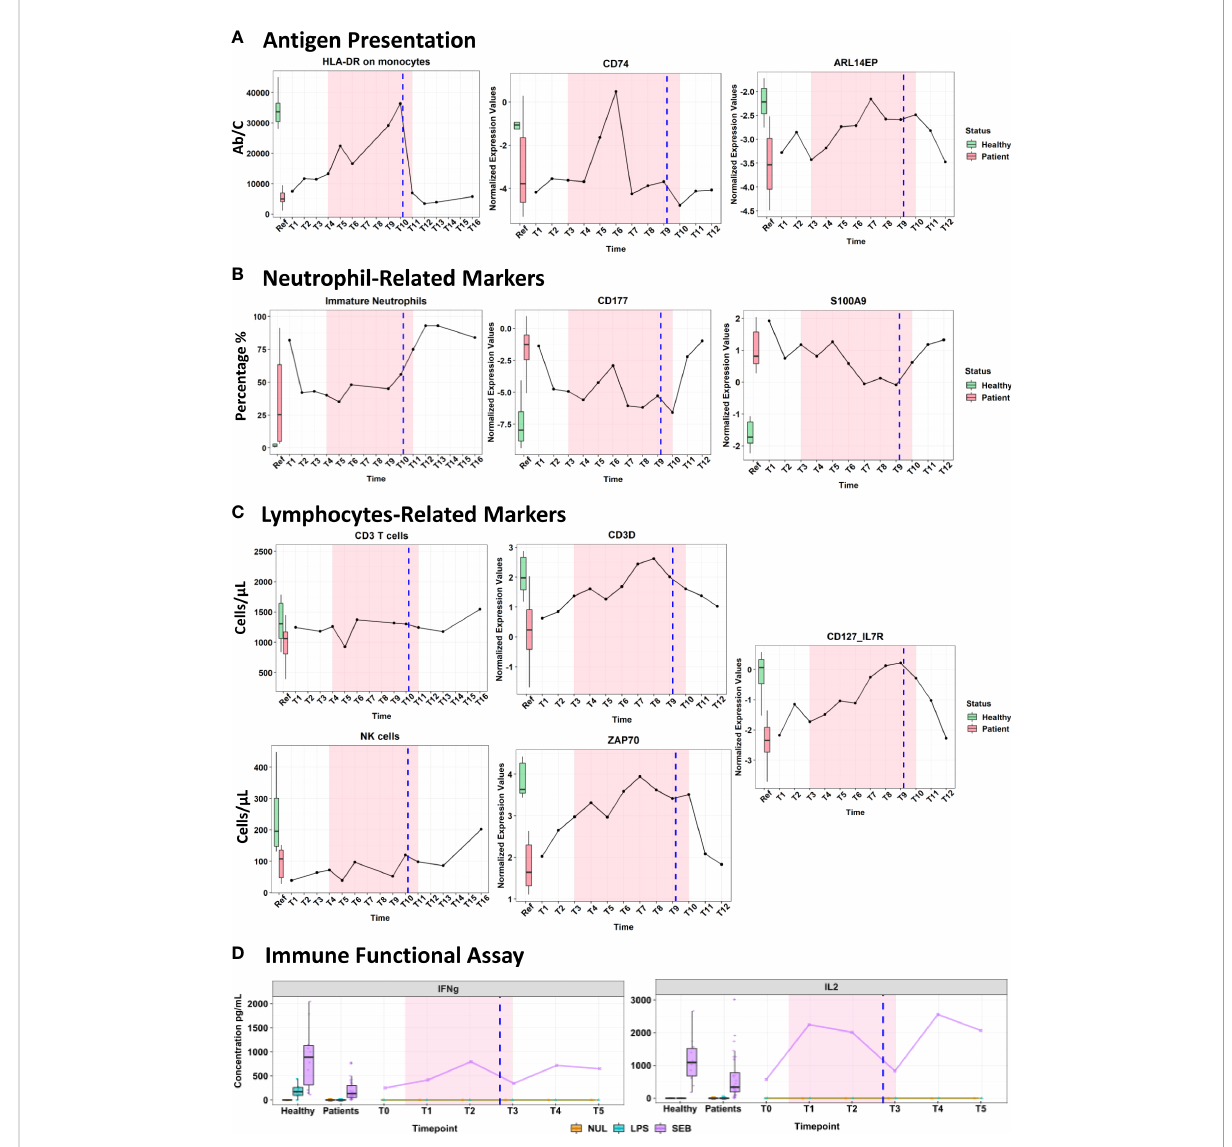
FIGURE 2 Immunomonitoring of cell surface markers using fl ow cytometry, transcriptomic analysis using the Immune pro fi ling Panel (IPP) prototype and cytokines measured by ELLA platform after being stimulated in Truculture ® tubes (Immune functional assays). Markers ’ measurements are represented on the y-axis, while the x-axis indicates the different time points measured. The highlighted pink area denotes the duration of the IFN- g treatment. The vertical blue line denotes the day of the surgery. The boxplots on the left illustrate expression levels in healthy volunteers (green) and ICU patients (red) as reference. (A) Evolution of antigen presentation pathway. (B) Neutrophil-related markers. (C) Lymphocyte- related markers. (D) Cytokine production after immune functional